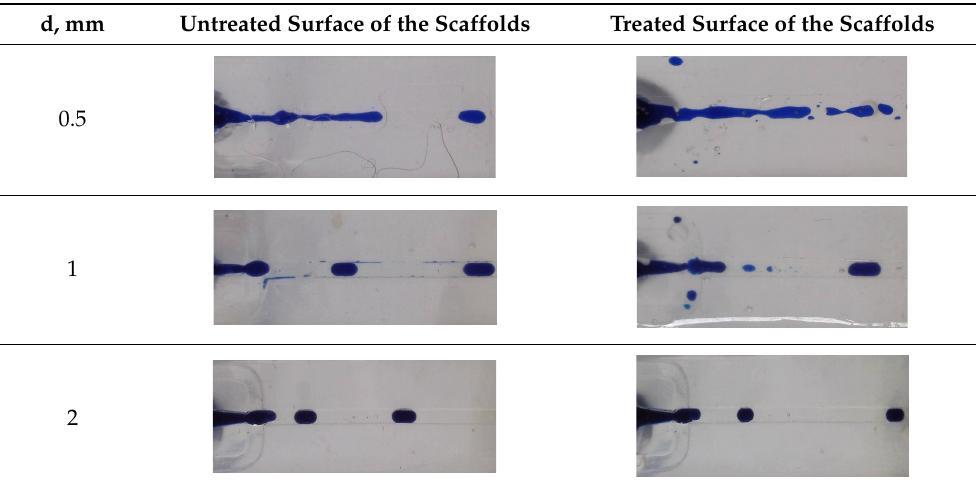
Table 5. Formation of droplets in microchannels of ESCARGOT chip with silicone walls (Figure 2c) with different scaffold thicknesses and treatment.